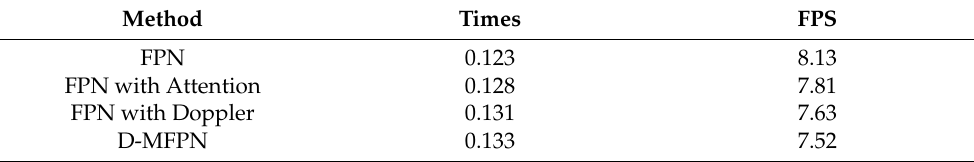
Table 2. Detection